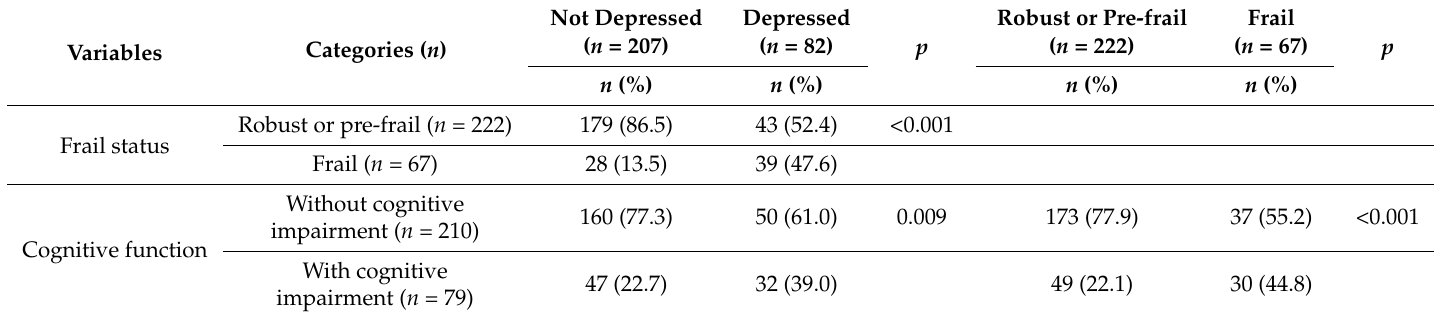
Table 2. Prevalence and associations of depression and frailty with cognitive impairment ( n = 289).